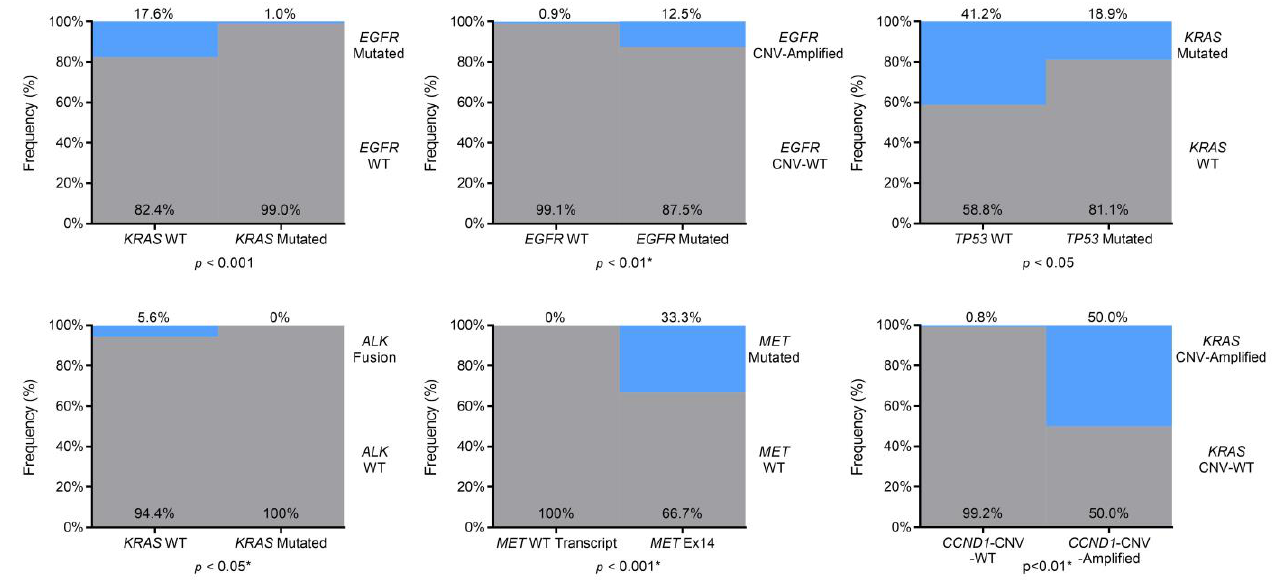
Figure 3. Mosaic plot showing relationships of co-occurrence and mutual exclusivity between the molecular alterations detected in our cohort. For each comparison, the most frequently altered gene is depicted on the X -axis. Frequency of patients included in each of the four subgroups defined by the presence/absence of both genetic alterations is depicted in the graph. * Comparison using Fisher’s exact test.